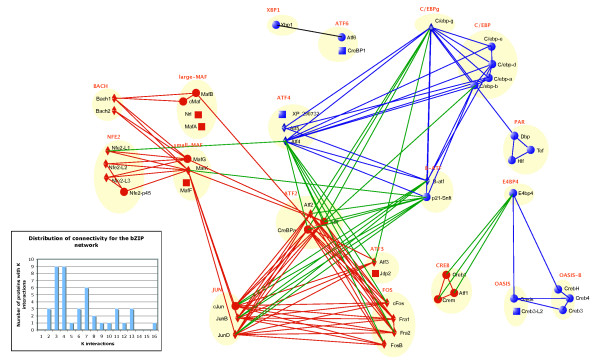
The bZIP dimerization network, integrating phosphorylation and redox information. Circles, diamonds and rectangles represent proteins that can homodimerize, cannot homodimerize, or for which no interaction data are available respectively. Proteins that contain C19 are coloured red, proteins that contain S19 or Y19 are coloured blue and proteins that contain A19 are coloured black. Interactions (vertices) that form C-C type dimers are coloured red, interactions that form C-X type dimers are coloured green, interactions that form S-S, S-Y or S-A type dimers are coloured blue. The bottom left diagram depicts the distribution of connectivity for the bZIP network, which does not appear to decay in a power-law.